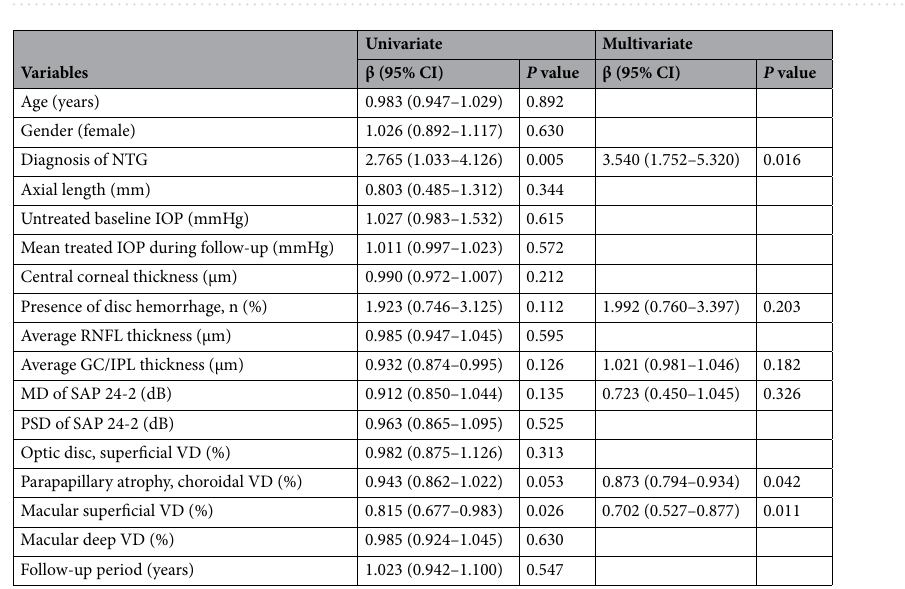
Figure 4. Longitudinal analysis of the initial paracentral scotoma to examine the pattern of progression. The average total deviation maps of the initial and final 10-2 VF tests for each subgroup are shown. A and B. The progression pattern of the initial paracentral scotoma of the primary open-angle glaucoma was deepened in the 4°–10° region, which deepened closer to the region of fixation in normal-tension glaucoma in the 0°–4° region.